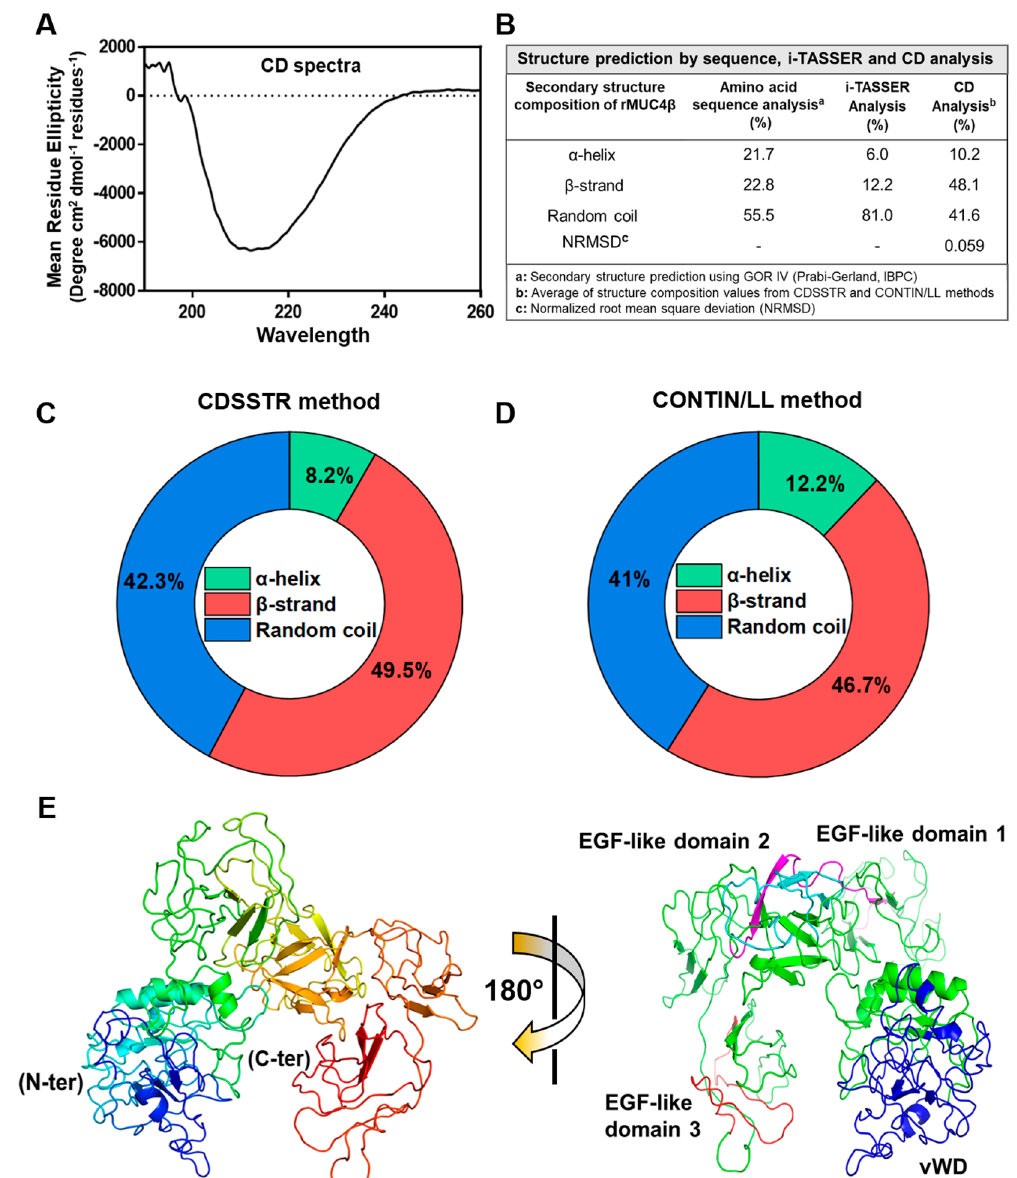
Figure 2. Biophysical characterization and secondary structure analysis of rMUC4β. ( A ) Far-UV CD spectra of rMUC4β were plotted using GraphPad Prism (https:// www. graph pad. com/ version 8). ( B ) Comparison of the percentage of secondary structure content estimated or predicted from CD spectrum, amino acid sequence, and I-TASSER analyses. The 2D multicolor pie chart is drawn using Origin 2019 software (https:// www. origi nlab. com/ version 9.6), showing the structure compositions estimated using ( C ) CDSSTR and ( D ) Contin-LL (Provencher and Glockner) methods. ( E ) Predicted structure of rMUC4β generated with the I-TASSER tool (https:// zhang group. org/I- TASSER/) and PyMOL Molecular Graphics System (https:// pymol. org/2/ version 2.3.4), Schrödinger, LLC. The cartoon structure of MUC4β indicating N-terminus (blue) and C-terminus (red). Right panel: i-TASSER predicted structure of rMUC4β rotated 180° to visualize the three EGF-like domains. EGF- like domain I (Cyan) and EGF- like domain II (Magenta) appear to be typical β-strand structures, while EGF-like domain III (Red) is a